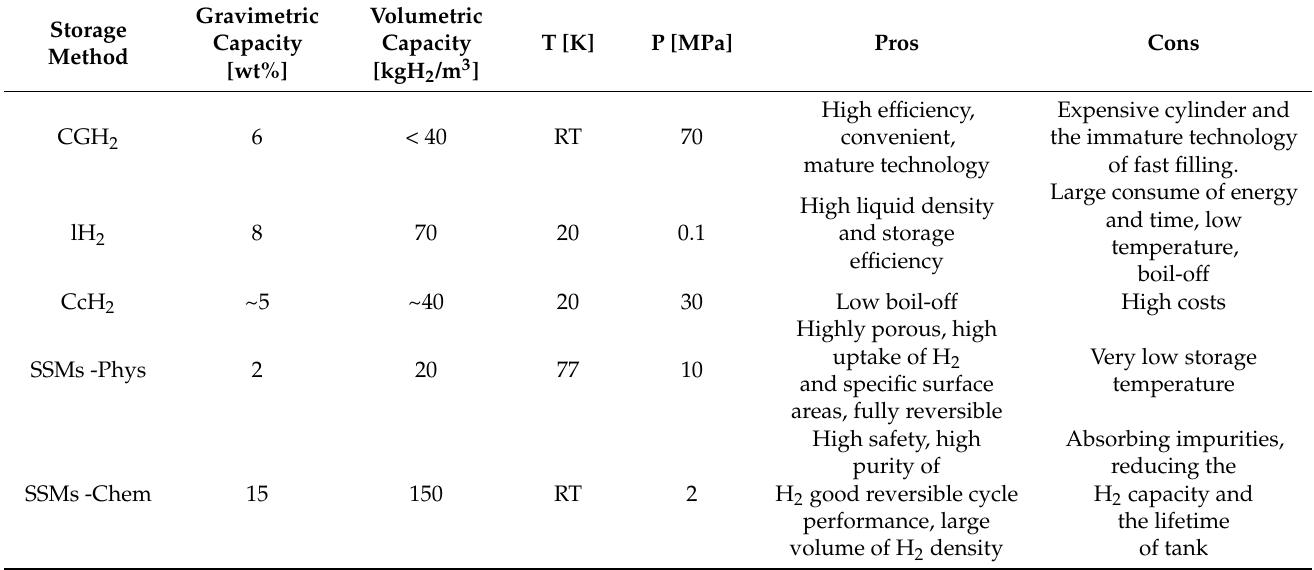
Table 1. Hydrogen storage systems